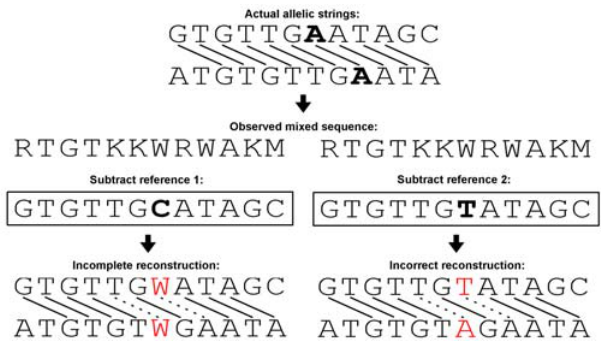
Figure 2. Examples of situations when the reference-based approach results in incomplete or incorrect reconstructions of a mixed sequence. Links between bases of the actual allelic strings (top) indicate positional homologies. The chosen reference sequences each differ from the top allelic string at one site (bold letters). Subtraction of Reference 1 results in one site in each reconstructed allelic string remaining unknown (red letters). Subtraction of Reference 2 results in one incorrectly reconstructed site in each allelic string (red letters). Note that, in the last case, the reconstructed fragment is heterozygous at two sites (dashed homology links). For the meanings of the IUPAC symbols see Figure 1.